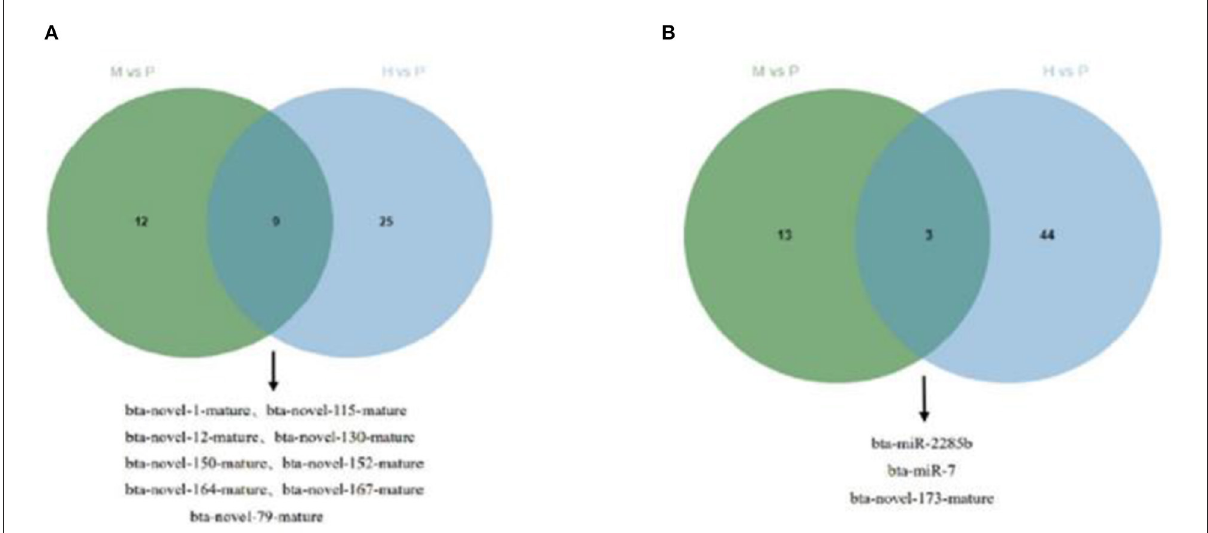
FIGURE7 Venn plot of cattle-yak miRNAs in the merged analysis between H vs. P and M vs. P. (A) Venn plot of u p- regulated miRNAs of cattle-yak in the merged analysis between H vs. P and M vs. P. (B) Venn plot of down-regulated miRNAs of cattle-yak in the merged analysis between H vs. P and M vs. P.